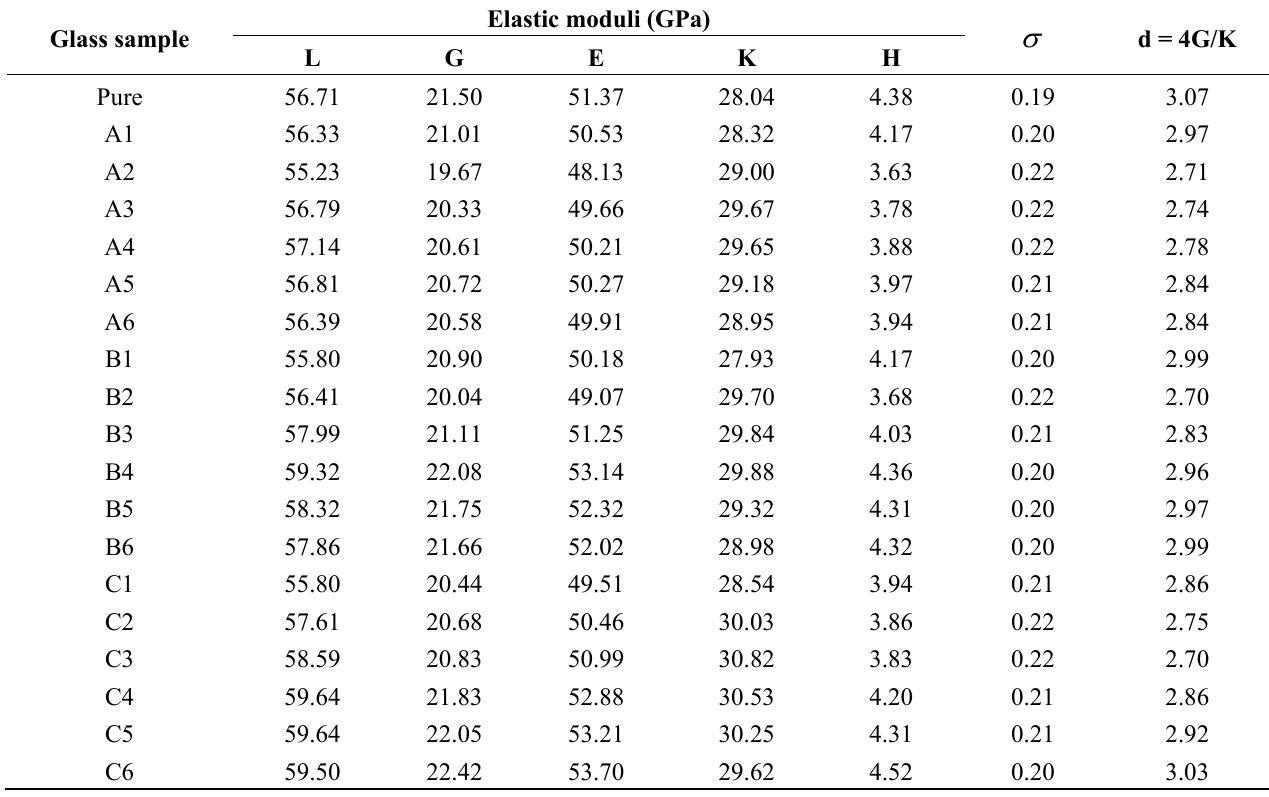
-ZnO-TeO glasses. The line is drawn to 3 2